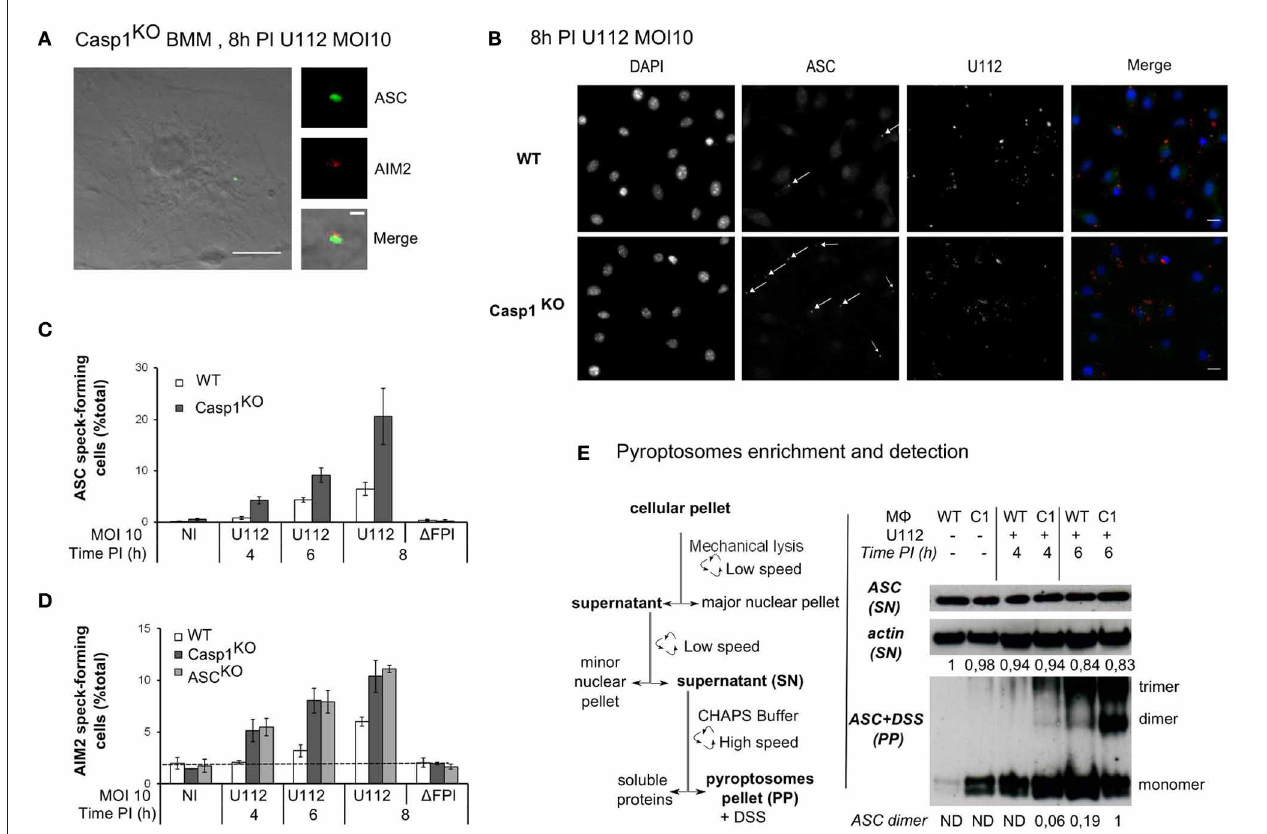
FIGURE 1 | ASC/caspase-1 negatively regulates AIM2 speck formation during Francisella infection. (A–E) BMM from the indicated genotypes were infected with F. novicida or the (cid:2) FPI mutant at a MOI of 10 for the indicated time. (A) Endogenous ASC (green) and AIM2 (red), (B) endogenous ASC (green) and U112 bacteria (red) were detected by immunofluorescence (scale bar: 10 μ m). Representative images are shown. (A) The inset corresponds to a magnification of the AIM2/ASC speck (scale bar: 1 μ m). ASC (C) and AIM2 (D) speck-forming cells were scored by